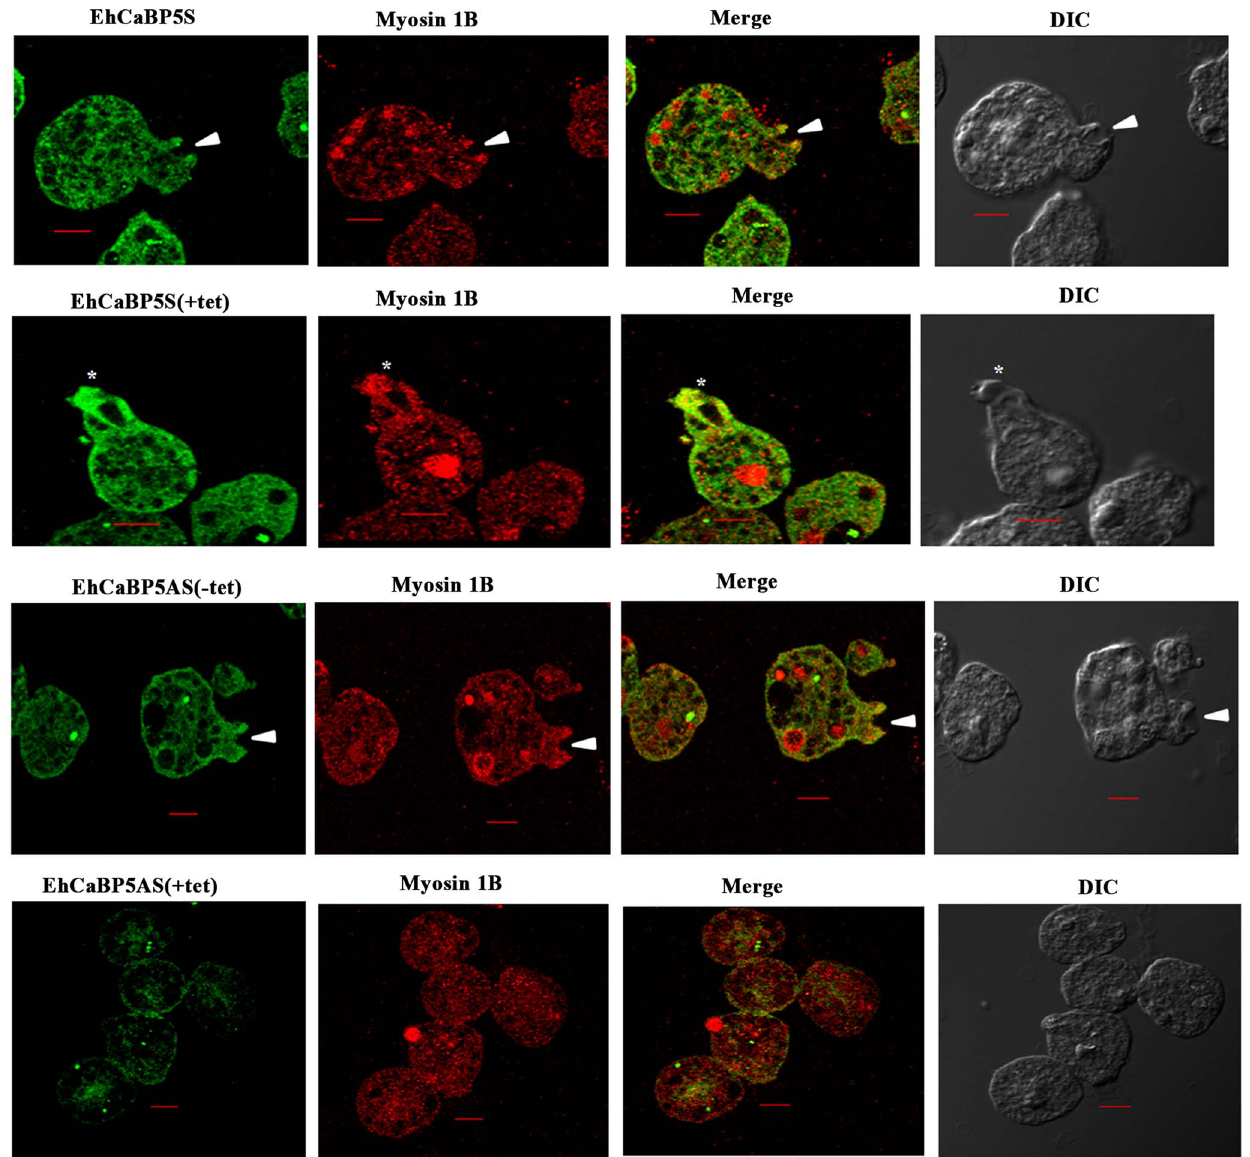
Fig 8. Erythrophagocytosis of cells overexpressing EhCaBP5 antisense and sense RNA constructs in the presence and the absence of tetracycline. Amoebic cells overexpressing EhCaBP5S and EhCaBP5AS with and without tetracycline were incubated with RBC for 10 min. The cells were then stained with Alexa 488(EhCaBP5) and myosin 1B (red). Solid arrow depicts the phagocytic cup and asterisk shows the phagosome. (scale bar, 10 m m; DIC, differential interference